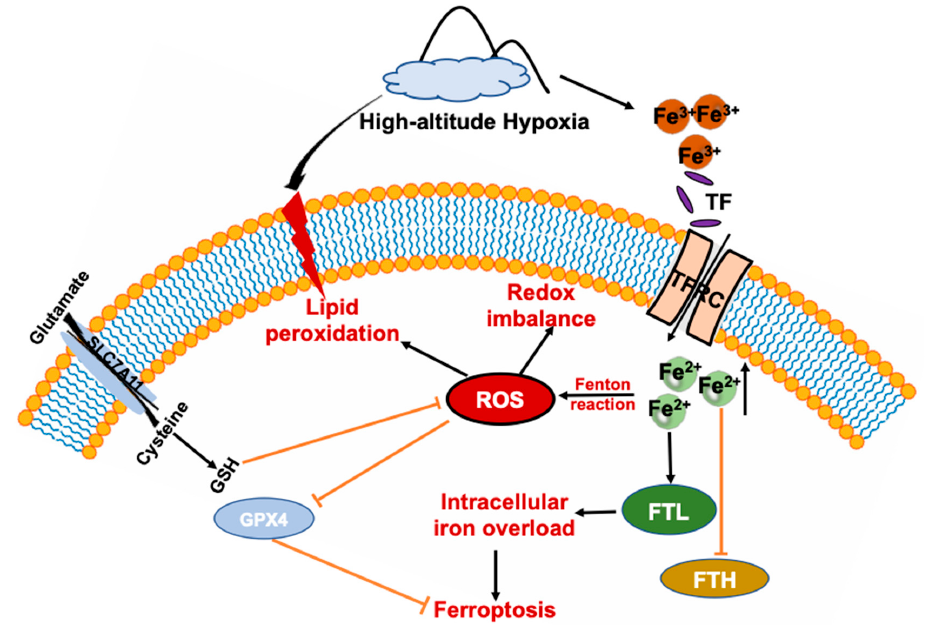
Figure 7. Schematic summary of HA-exposure-induced adipose tissue ferroptosis. HA disturbs iron homeostasis via differentially regulated iron uptake and storage-related genes and proteins such as TFR, FTH, and FTL, leading to iron overload in both WAT and BAT, that soon afterwards induces adipose tissue to produce massive amounts of ROS and cause redox imbalance, and lipid peroxidation. Ultimately, adipose tissue is more prone to ferroptosis response after exposure to HA.